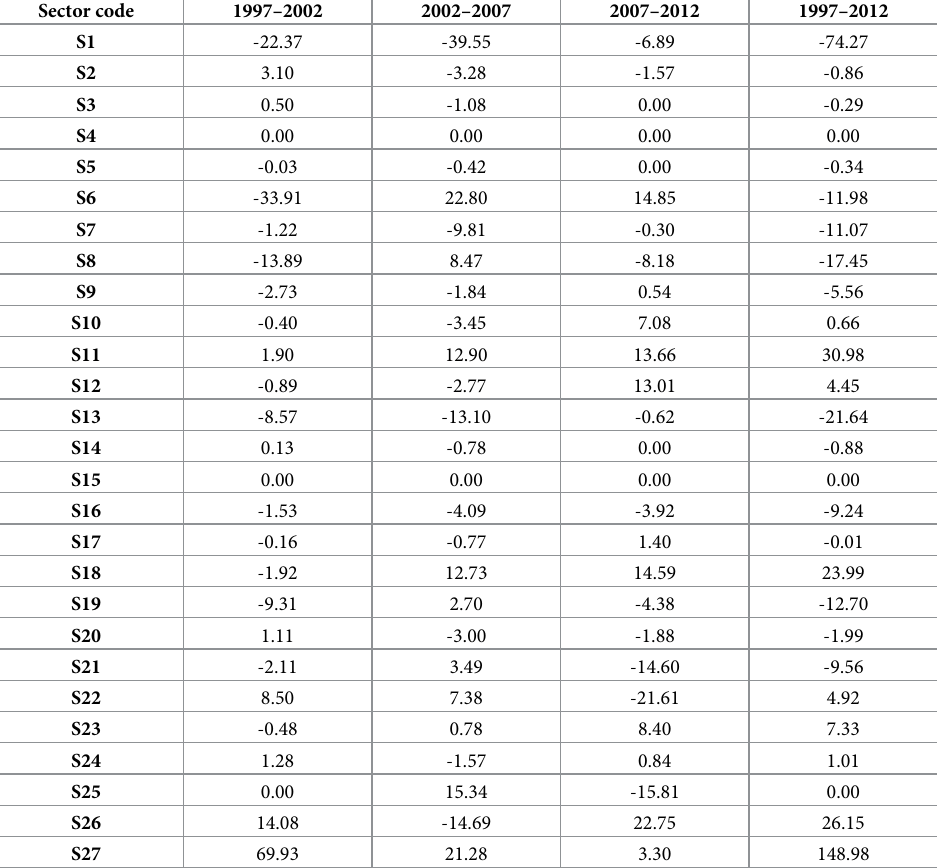
Table 4. Comparison of within-group consumption substitution effects: Contributions to changes in household indirect energy consumption (unit: